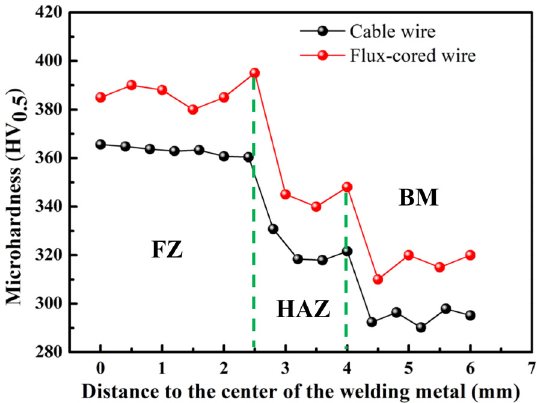
Figure 14. Microhardness comparison of flux-cored wire and cable wire welding joints.